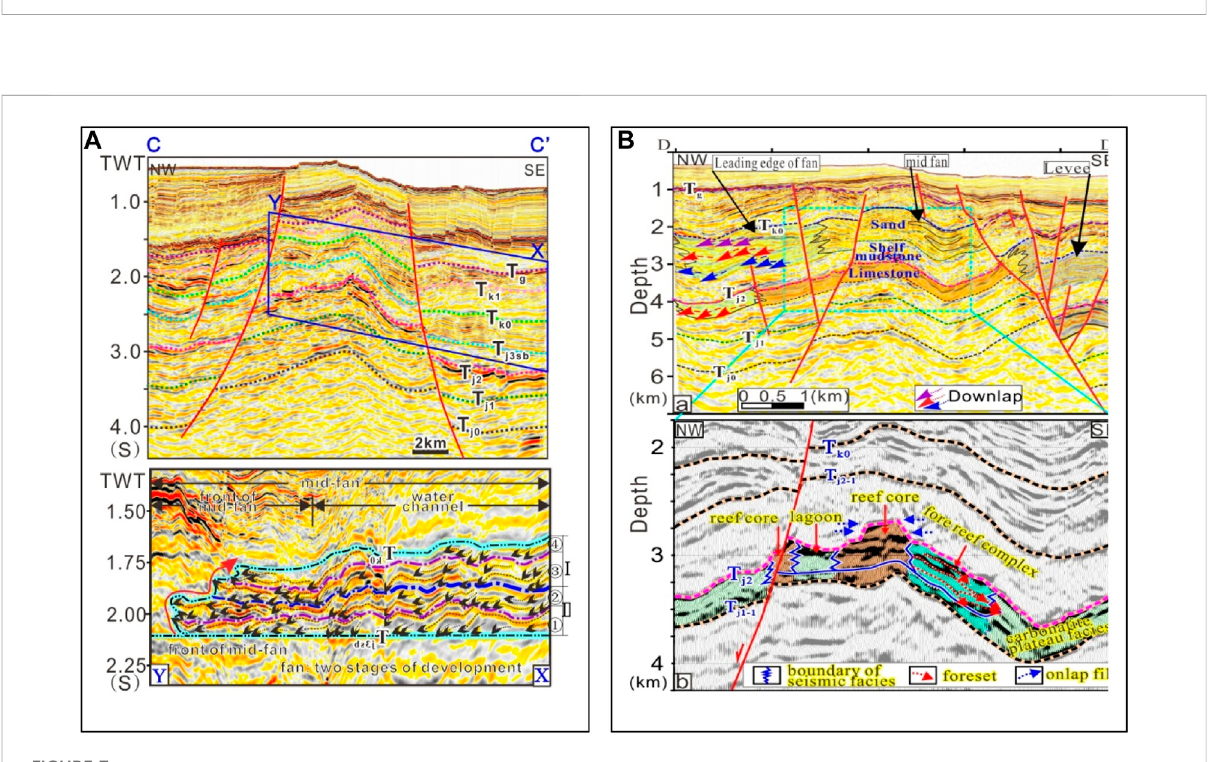
FIGURE 7 Reservoir layer of DS-A, location see Figure 1. (A) Interpretation for J 3 fan in DS-A; (B) interpretation for J 2 limestone in